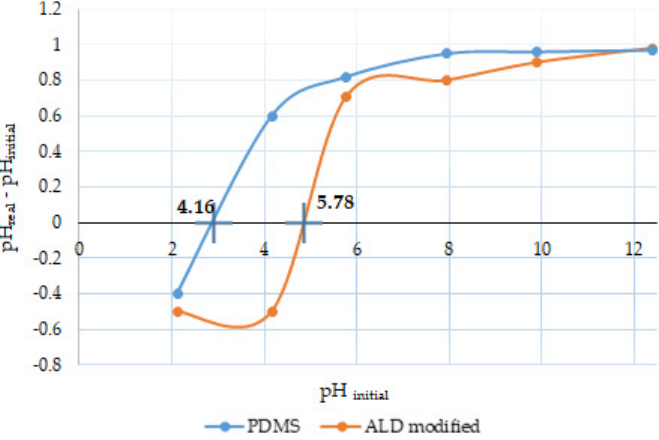
Figure 13. Surface charge of PDMS and ALD-modified PDMS membranes.